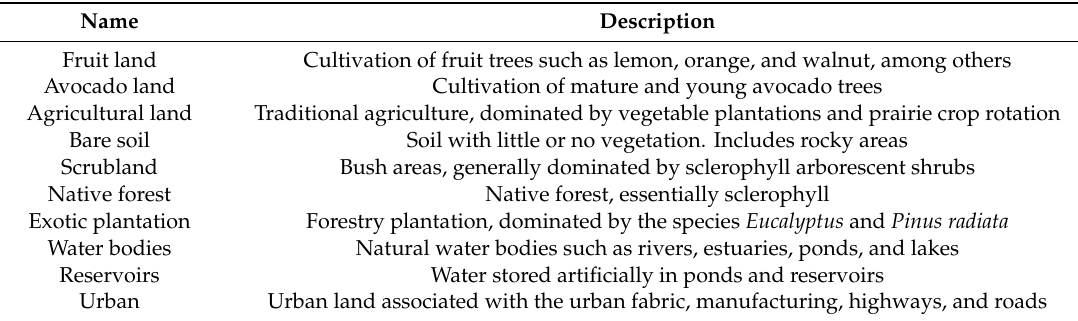
Table 2. Description of the land uses employed in the